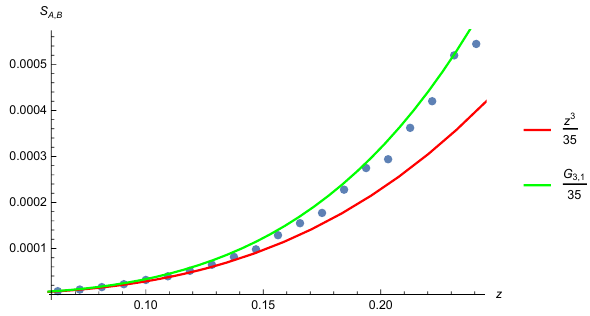
Figure 8 . Mutual information of two balls for 4 d free Dirac fermion, 0 < z < 0 : 25. The red line is the leading order contribution in z , while the green line is the leading order conformal